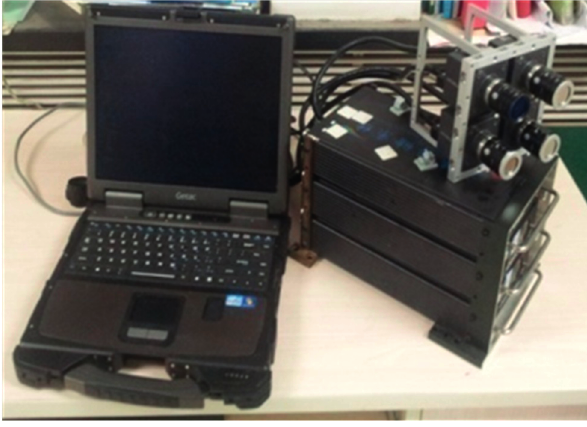
Figure 1. The four-camera multispectral mapping